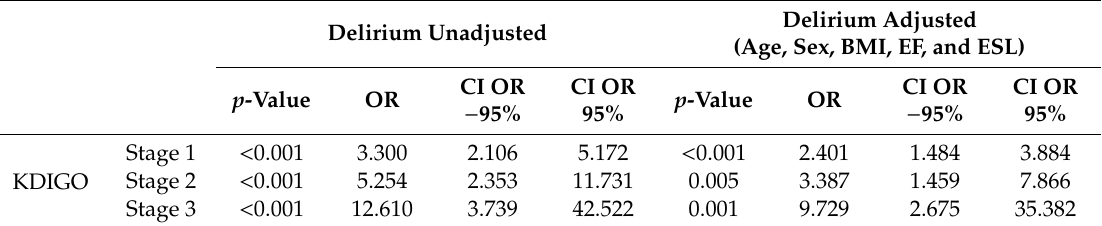
Table 5. Unadjusted and adjusted KDIGO staging and the risk of POD development.